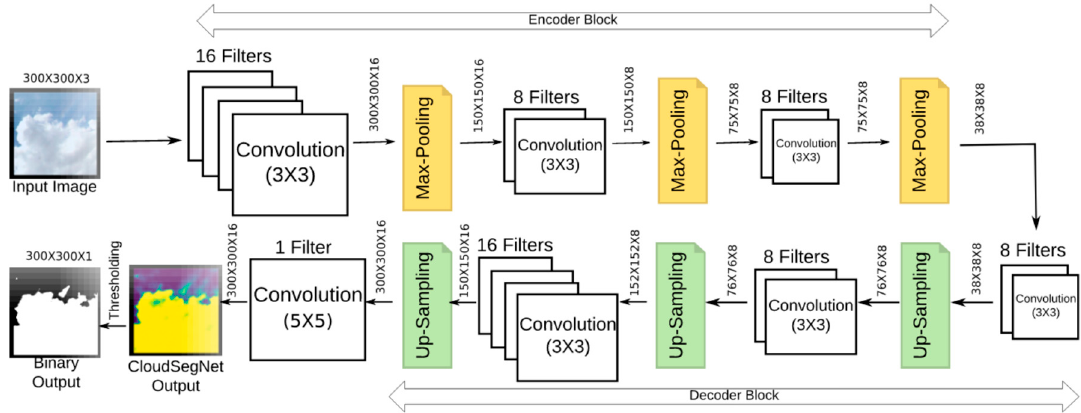
Figure 4. Architectural overview of CloudSegNet (taken from [41]).